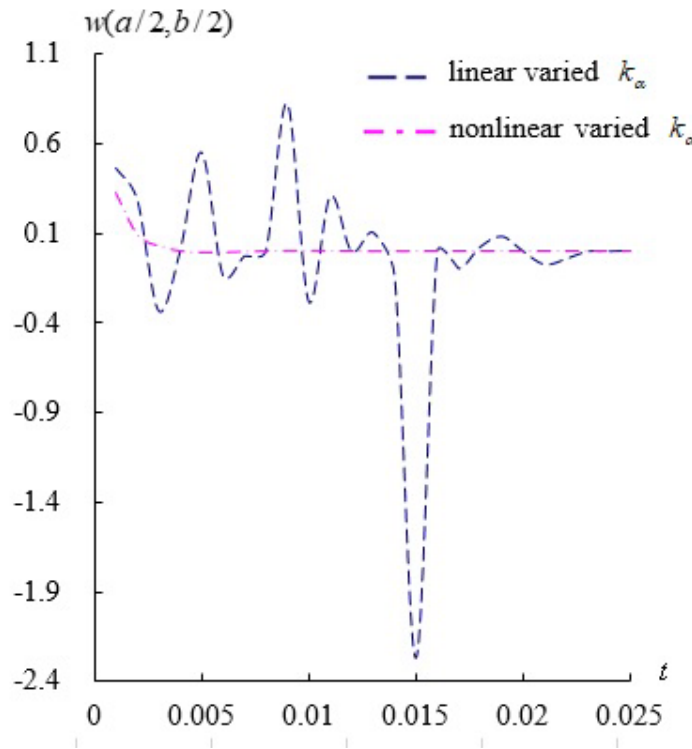
Figure 7. Transient response of w ( a /2, b /2 ) (unit mm) vs. t (unit s) compared with nonlinear and linear varied k α .